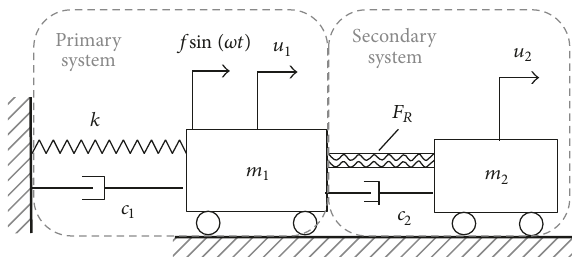
Figure 1: 2DOF SMA oscillator representing the primary system connected to the ATVA (secondary